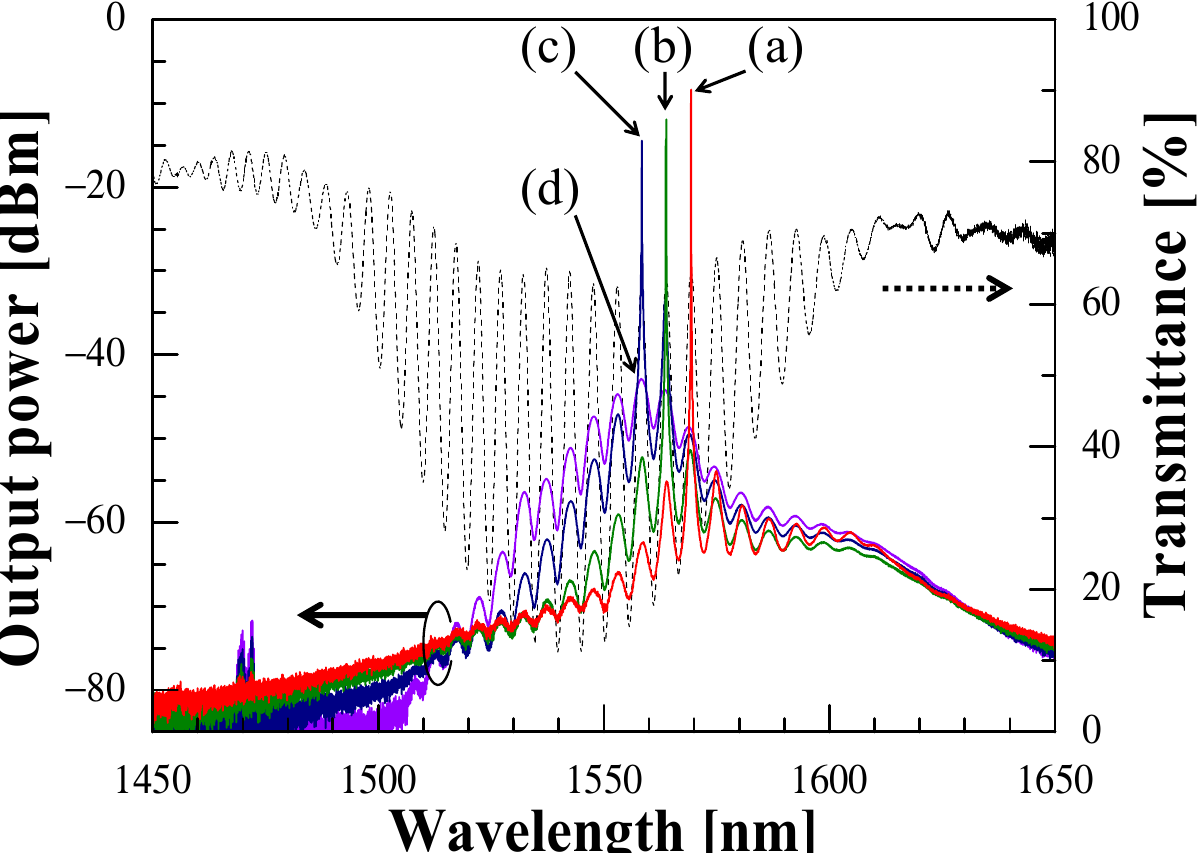
Figure 2. Oscillation spectra of the EDFRL at room temperature (~29 °C) with different VOA losses: ( a ) 0 dB, ( b ) 7 dB, ( c ) 15 dB, and ( d ) 30 dB.